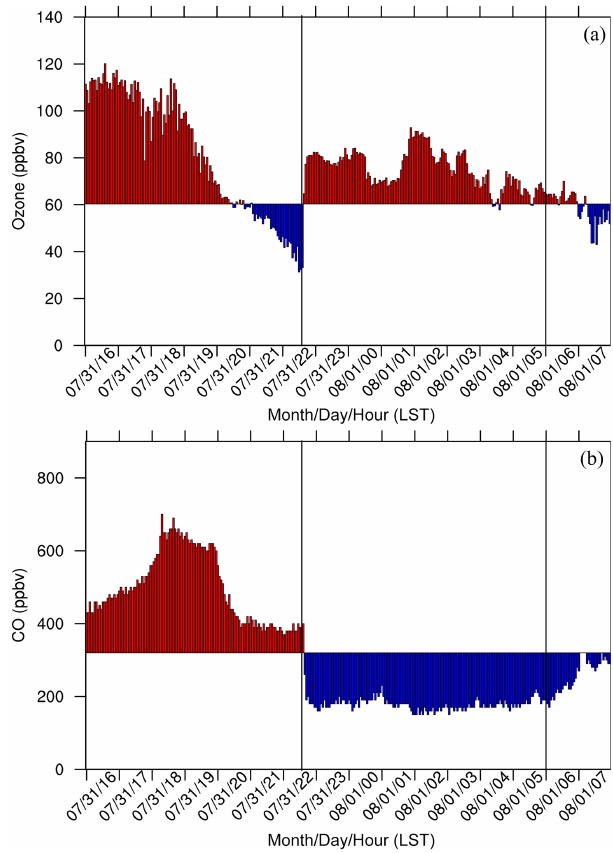
Figure 4. (a), (b) Surface ozone and CO concentrations (unit: ppbv) at the SHATLE field campaign site located in Zhanhua county of Binzhou city, measured with a 3min temporal resolution from 16:00 LST on 31 July to 08:00 LST on 1 August 2021. The 10d averaged ozone and CO concentrations at the site are used as the baseline, and positive (negative) departure from the 10d averaged concentration is shown in red (blue) color. The two vertical black lines represent the observed ozone surge period between 22:36 LST on 31 July and 06:00 LST on 1 August 2021. Labels along the hor- izontal axis represent the observation times